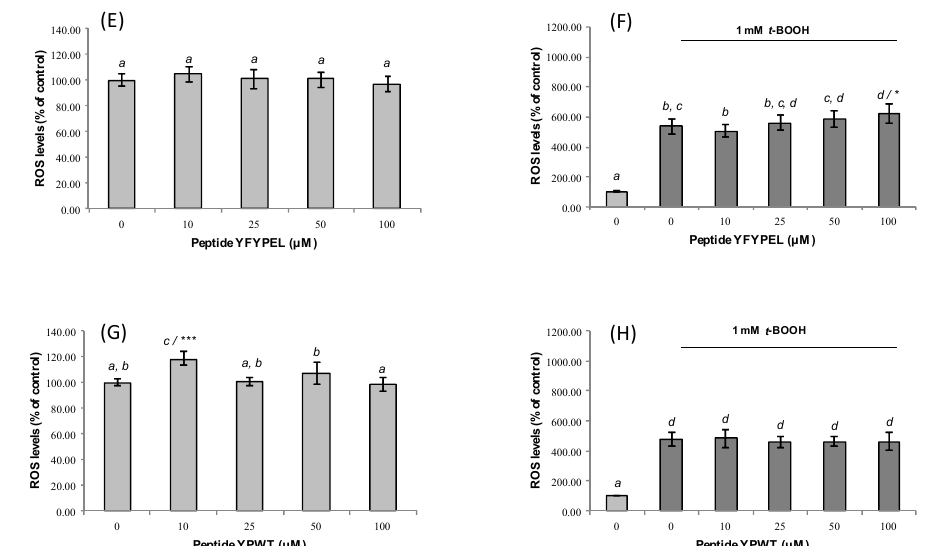
Figure 4. Dose-dependent effects of synthetic animal-protein derived peptides ( A , B ) RYLGYLE, ( C , D ) YLGYLE, ( E , F ) YFYPEL, and ( G , H ) YPWT on ROS production in non-stressed macrophages RAW264.7 ( A , C , E , F ) and macrophages RAW264.7 stressed with tert-butyl hydroperoxide ( t -BOOH, 0.25 mM). Cells were pre-treated with peptides at concentrations that ranged from 10 to 100 μ M for 24 h. Results were expressed as percentage of ROS levels compared to control, which was considered as 100% (% control, mean ± standard deviation (SD), n = 3. Different letters indicate significant differences ( p < 0.05) and *** ( p < 0.001); ** ( p < 0.01); * ( p < 0.05) significant differences of each concentration versus control under the same experimental conditions (one-way ANOVA followed by Tukey’s multiple comparison test).